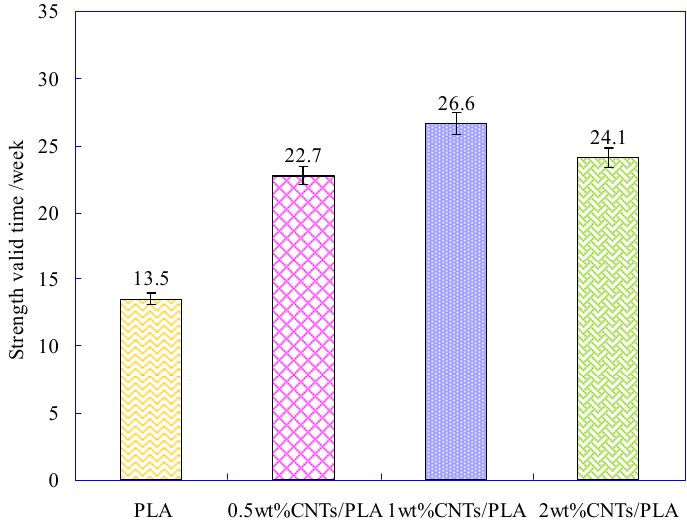
Figure 8. The strength valid time of pure PLA suture and CNTs / PLA sutures.